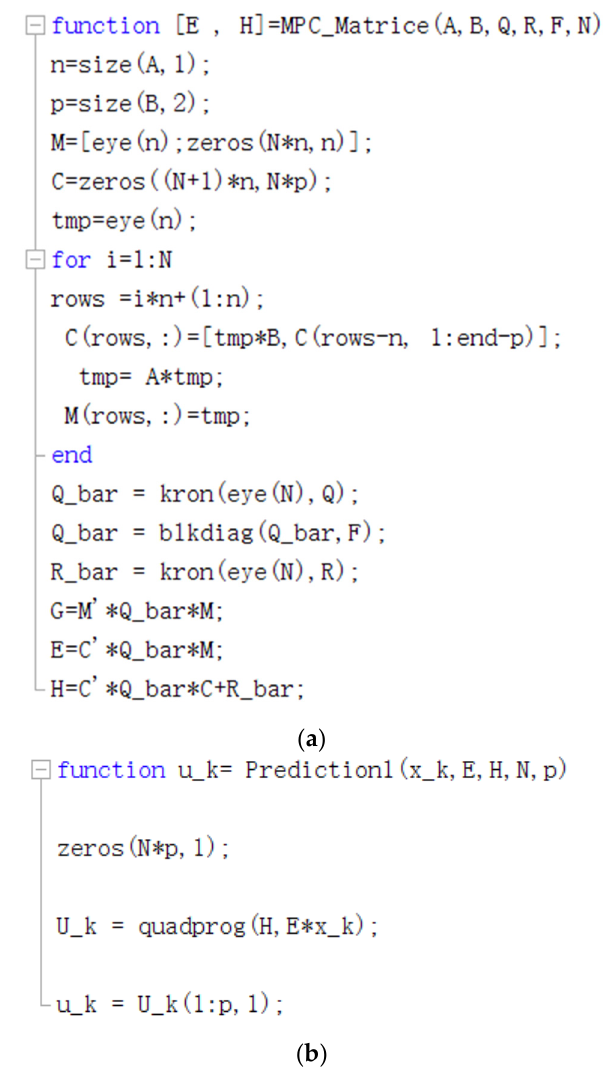
Figure 6. ( a ) MPC algorithm code; ( b ) MPC algorithm code.